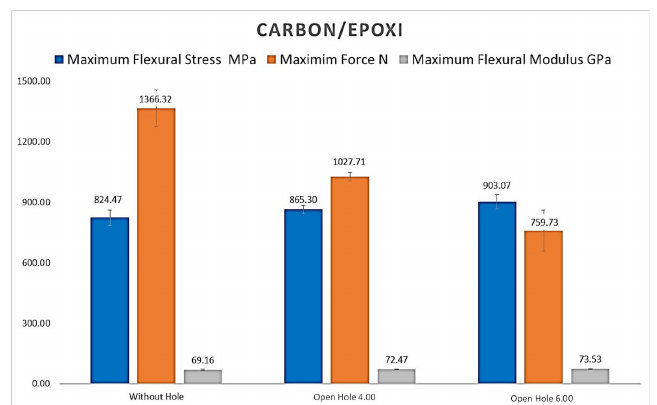
Figure 6. Comparison of the averages of maximum bending strength, maximum force and maximum flexural modulus for specimens without hole and with hole of 4 and 6 Table 5. Stress concentration ( K